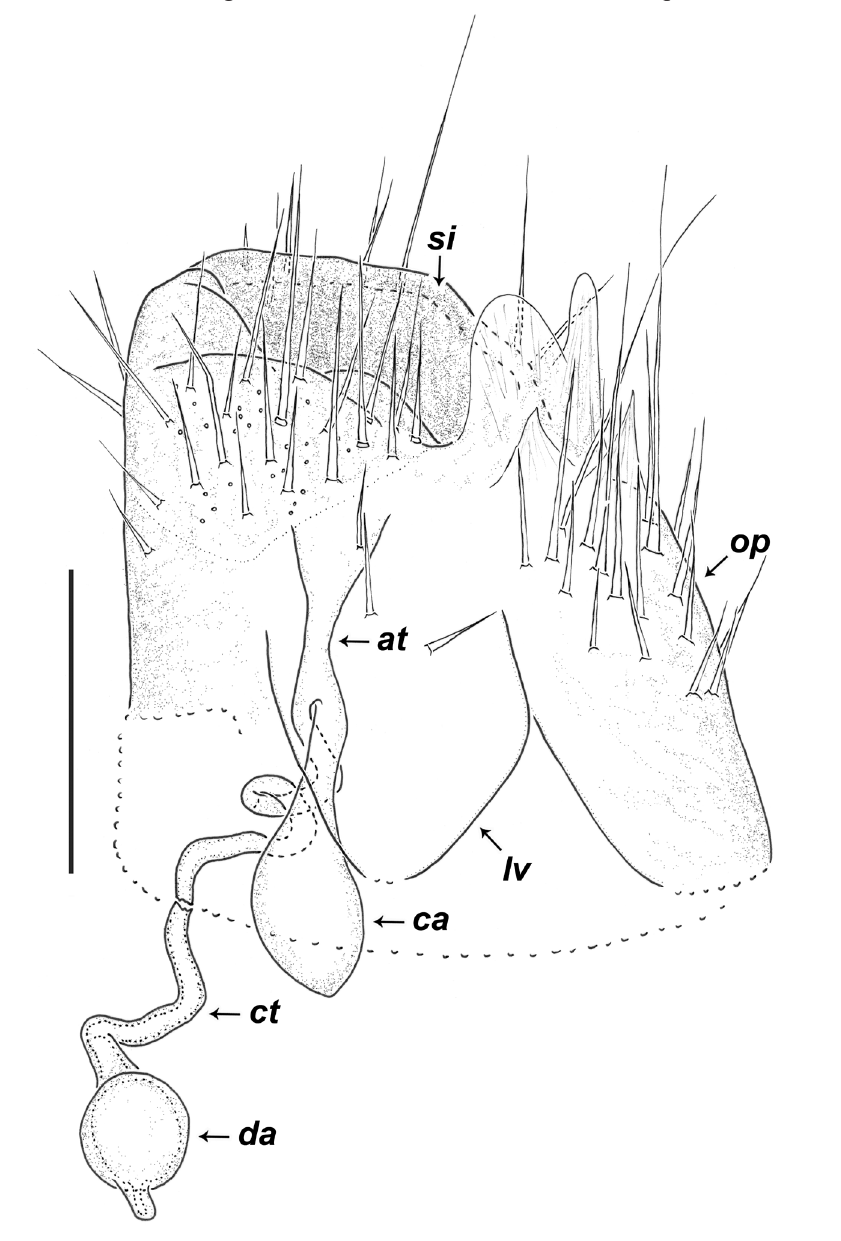
Fig. 3. Right vulva of Enghophyllum naxium , female from Antiparos Island, anterior view. – at = apodematic tube; ca = central ampulla; ct = connecting tube; da = distal ampulla; lv = lateral valve; op = operculum; si = sinus. Scale bar: 0.2